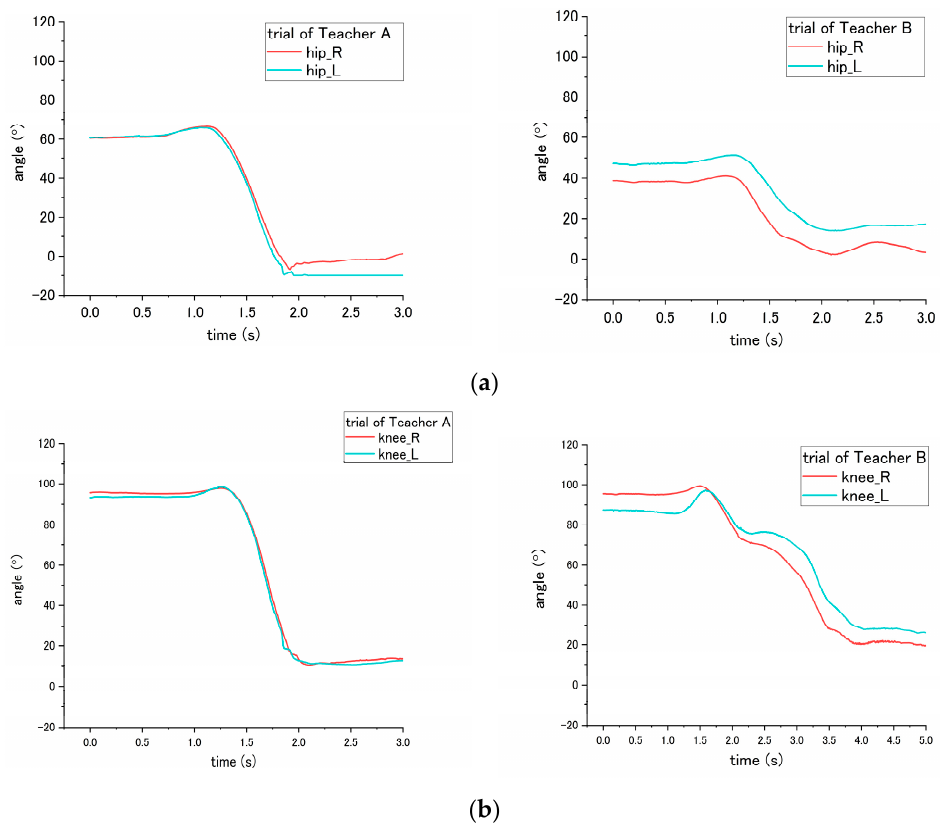
Figure 15. Flexion angle of patient’s ( a ) hip and ( b ) knee during step No. 11 when correct way was conducted at steps No. 5, 6 and 11.